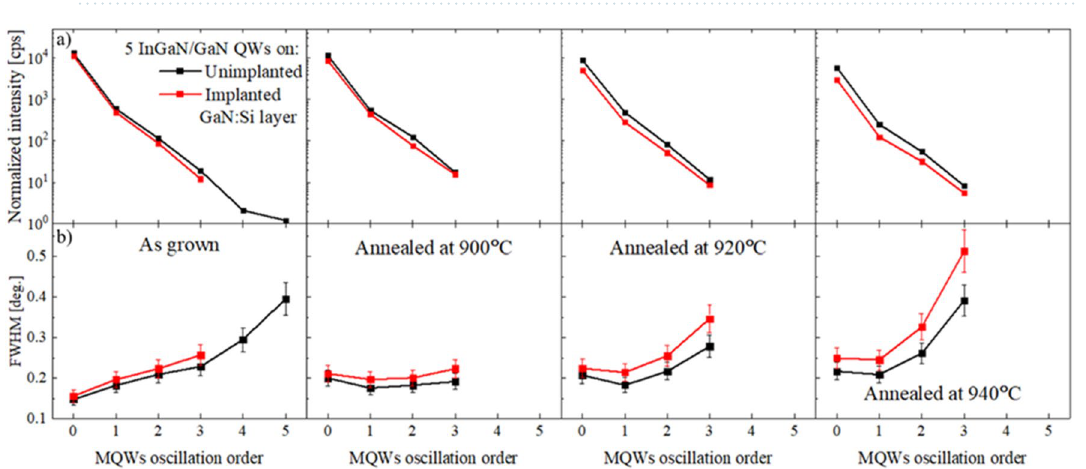
Figure 11. HRXRD data analysis of normalized intensity ( a ) (error at the level of 5% of the value) and FWHM ( b ) (error at the level of 10% of the value) of the Pendeloesung frings of MQWs grown on the unimplanted and implanted GaN:Si and after annealing at 900 °C, 920 °C and 940